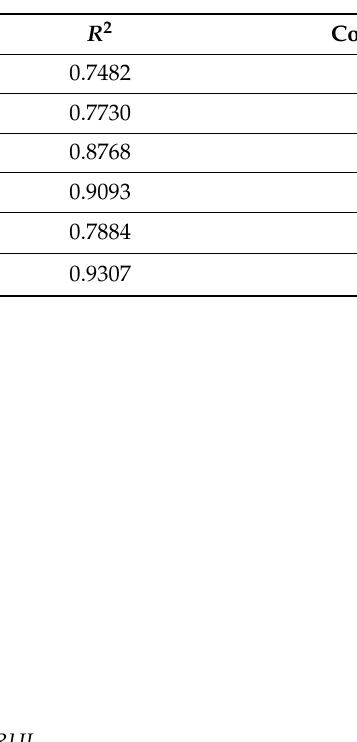
Figure 6. Cycle performance of LFP/NCM solid-state lithium polymer batteries: discharge capacity decreases with cycle numbers. Table 2. The six mathematical formulas generated by the SR model.